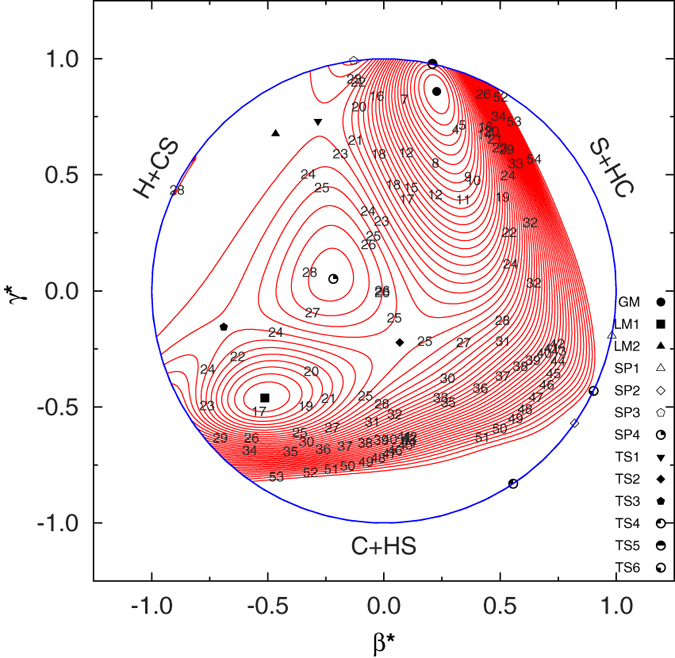
Relaxed triangular plot of new PES in hyperspherical coordinates.The location and symmetry of all stationary points are displayed. Contours equally spaced by 0.004Eh, starting at −0.3613Eh.